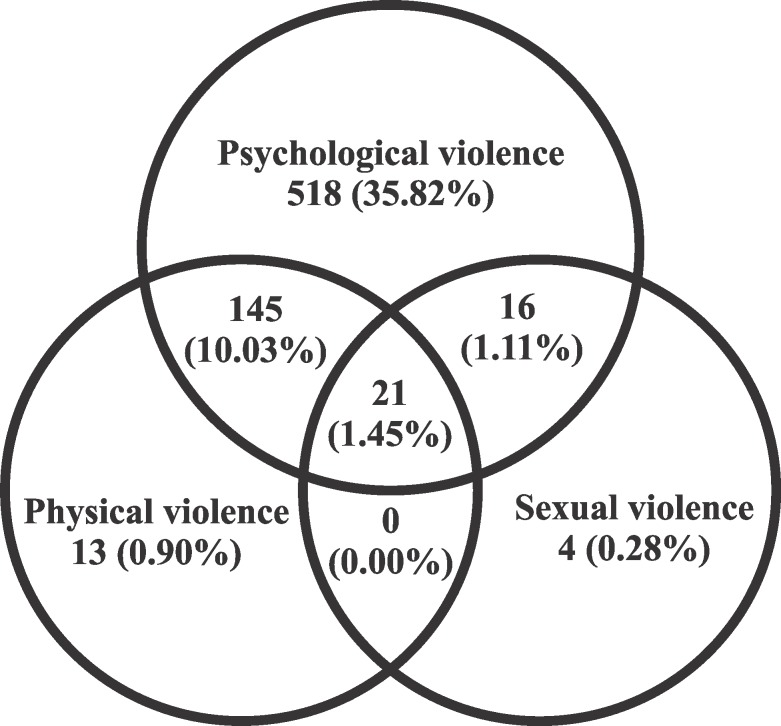
Venn diagram showing frequencies and percentages of psychological, physical and sexual violence against pregnant women in São Luís, 2010–2011.